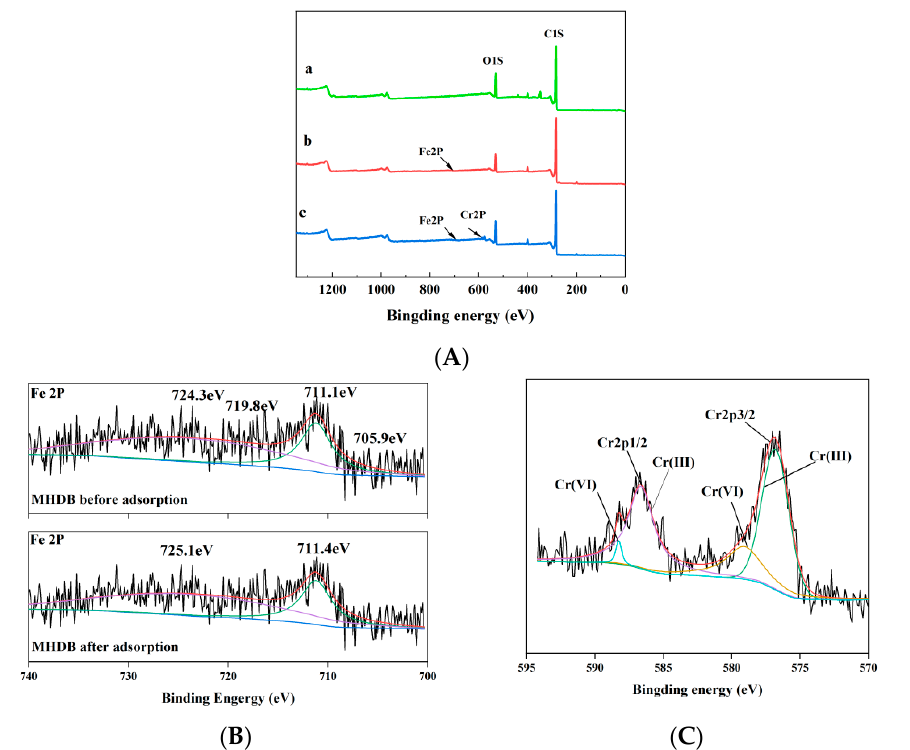
Figure 4. ( A ) The full XPS spectra of (a) HDB, (b) MHDB, (c) MHDB after adsorption; ( B ) detailed graph of the Fe 2p before and after adsorption; ( C ) detailed graph of the Cr 2p after